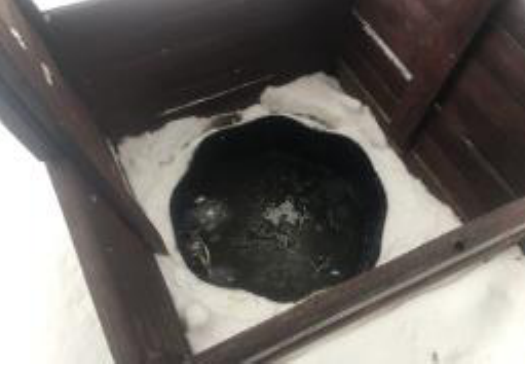
Figure 4. Ice storage tank location.